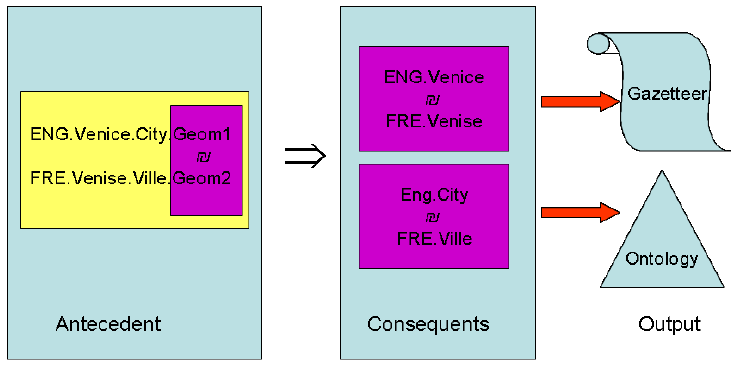
Figure 12. Example illustrating the Rule 2.